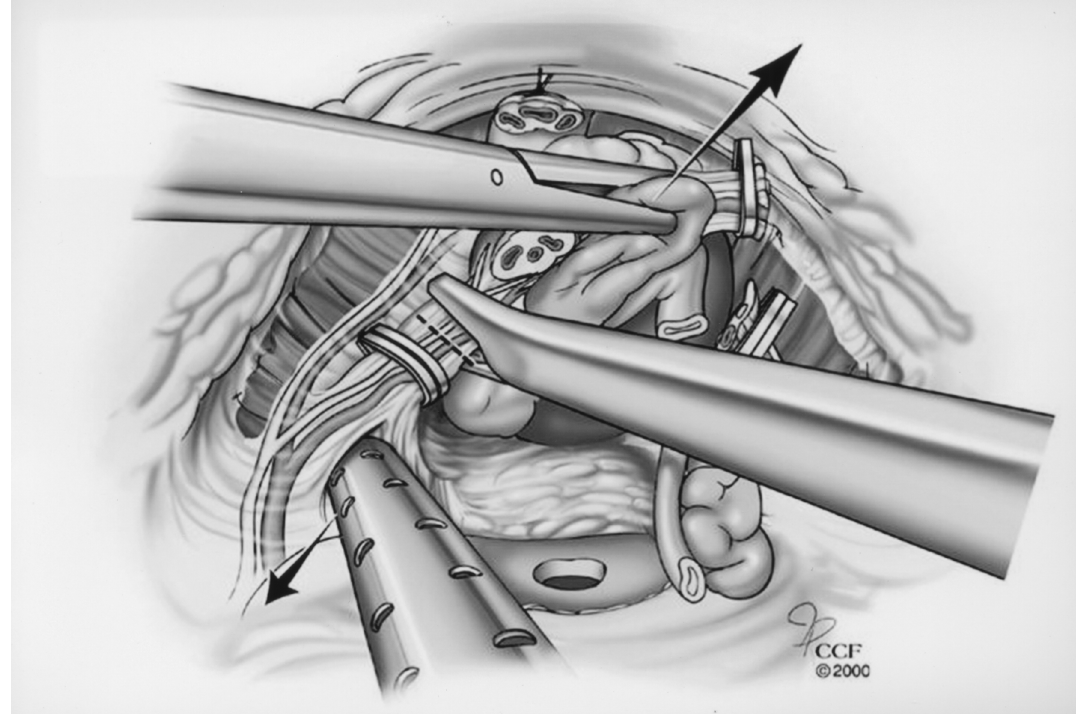
Figure 3 – During a nerve-sparing procedure, the lateral pedicles are defined and controlled with non-metallic locking